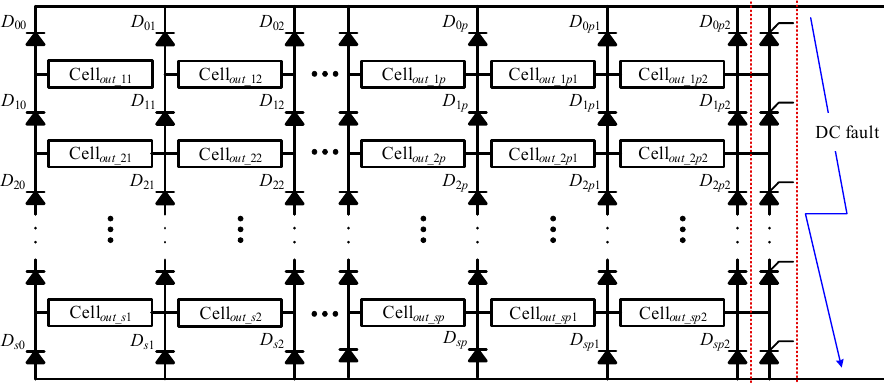
Figure 12. Addition of thyristors to protect secondary diodes under DC fault.